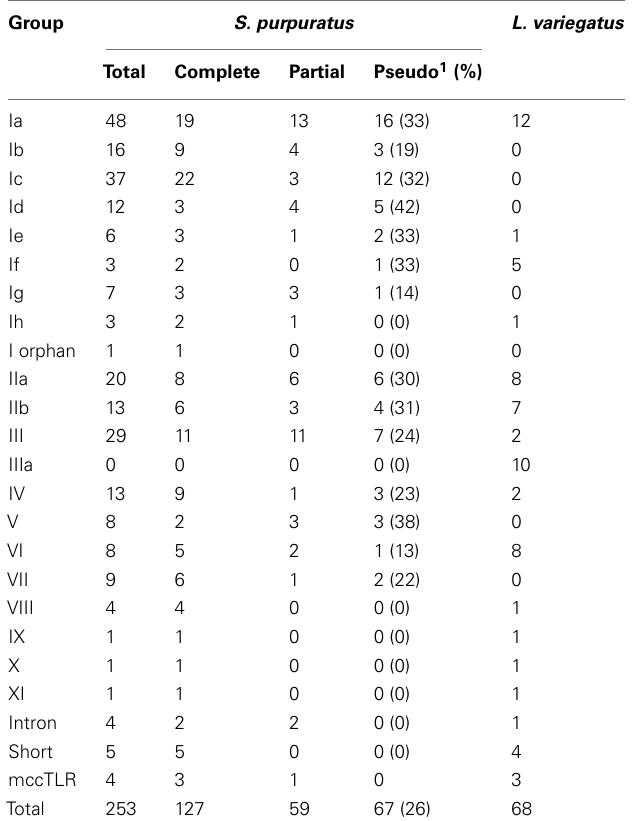
Table 3 | Sizes of sea urchinTLR